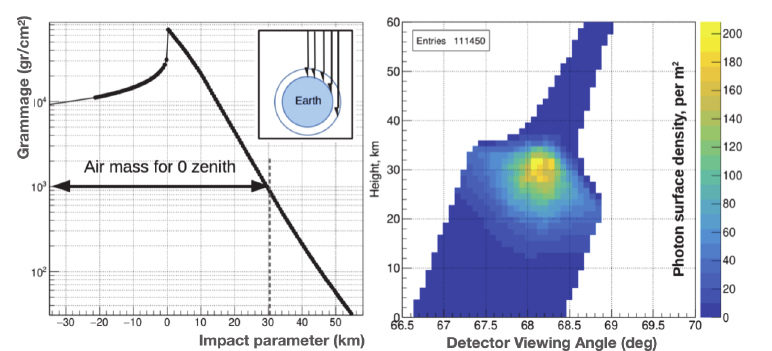
Figure 2: Left: Grammage of a cosmic particle as a function of its impact parameter. The insert at the top-right schematically shows incoming particles with di ff erent impact parameters. In case the impact parameter is larger than the radius of the Earth, the maximum air mass seen by the particle doubles. Right : Photon surface density (z-axis) as a function of the viewing angle and height of a UHECR (primary particle: 100 PeV proton) estimated with EASCherSim [11] (see Sec. 3). The total number of simulated protons is about 1 . 1 × 10 5 .